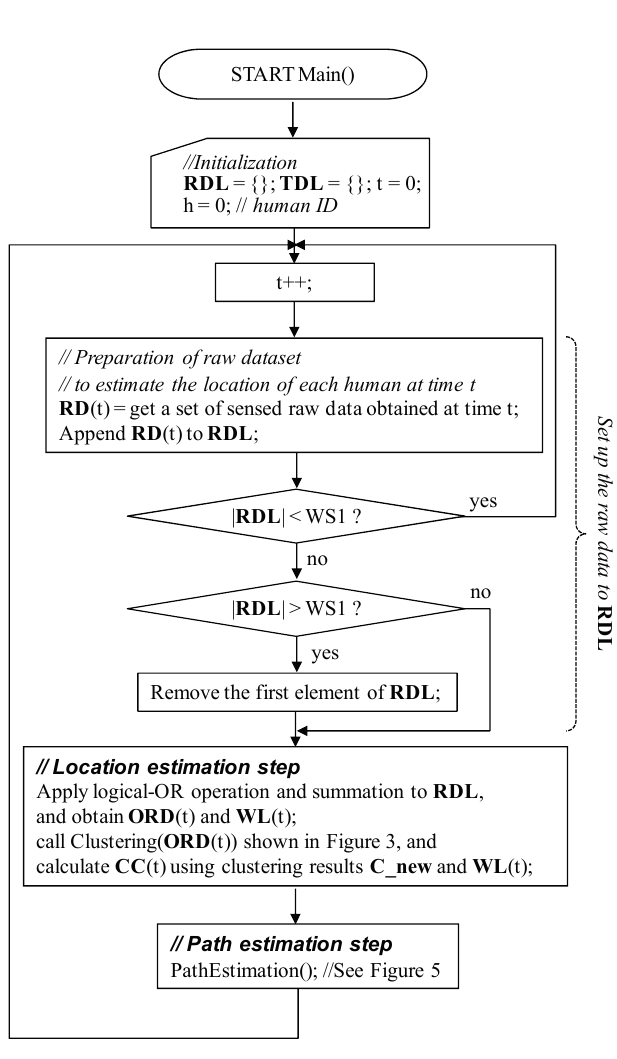
Figure 1. Main procedure of the proposed